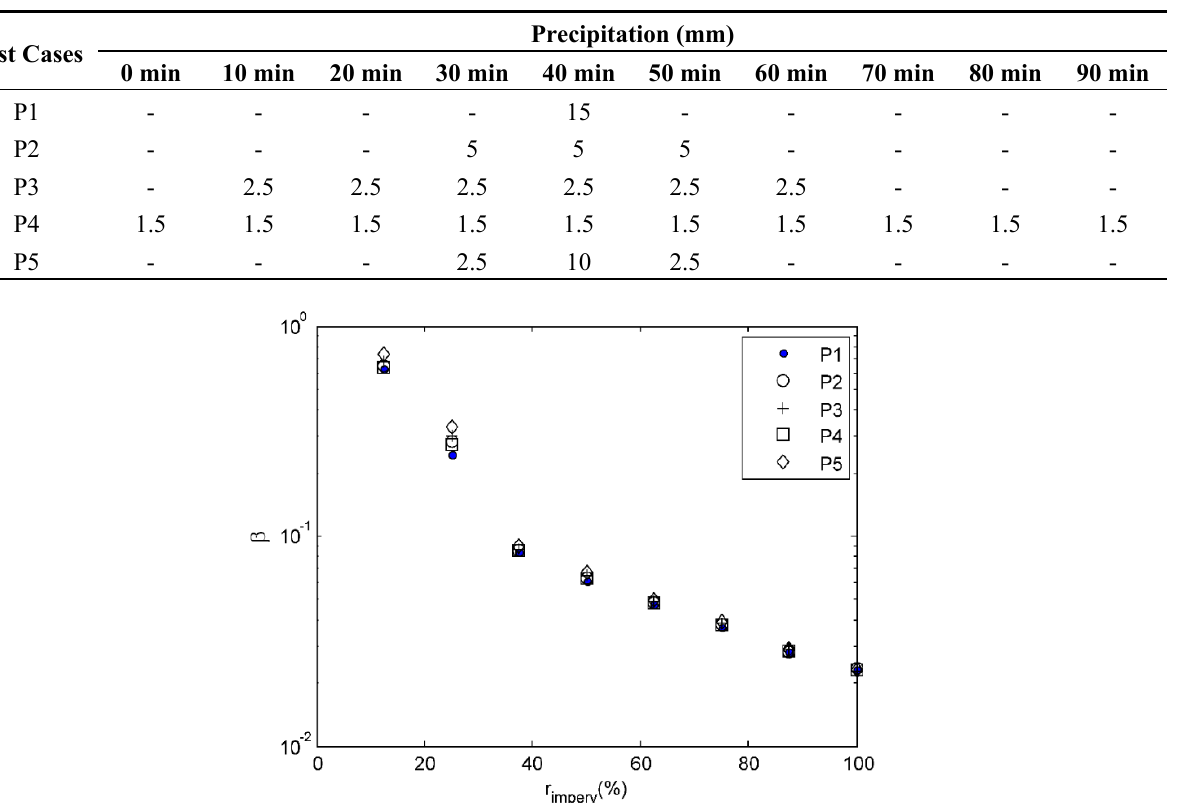
Table 3. Cases of temporal rainfall variation evaluated for equivalent dendritic networks.